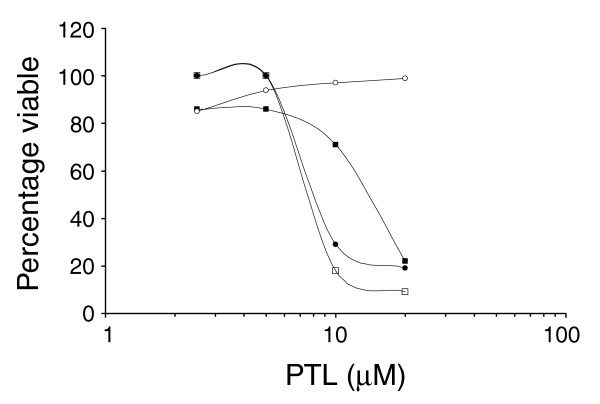
PTL induces apoptosis in primitive cancer cells. Percent viability of prostate cancer cells and cells from a patient with BPH treated with increasing concentrations of PTL. Cells were cultured for 1 h with 100 ng/ml TNFα prior to treatment with PTL for 18 h. Cells were subsequently labeled with CD133-APC, Annexin-V-FITC and DAPI. Viability was defined as annexin-V-/DAPI- on total cells. Three prostate cancer patients' samples were analyzed and a representative profile is shown of normal CD133+ (open circles), cancer CD133+ (filled squares), normal progenitor (filled circles) and cancer progenitor (open squares).